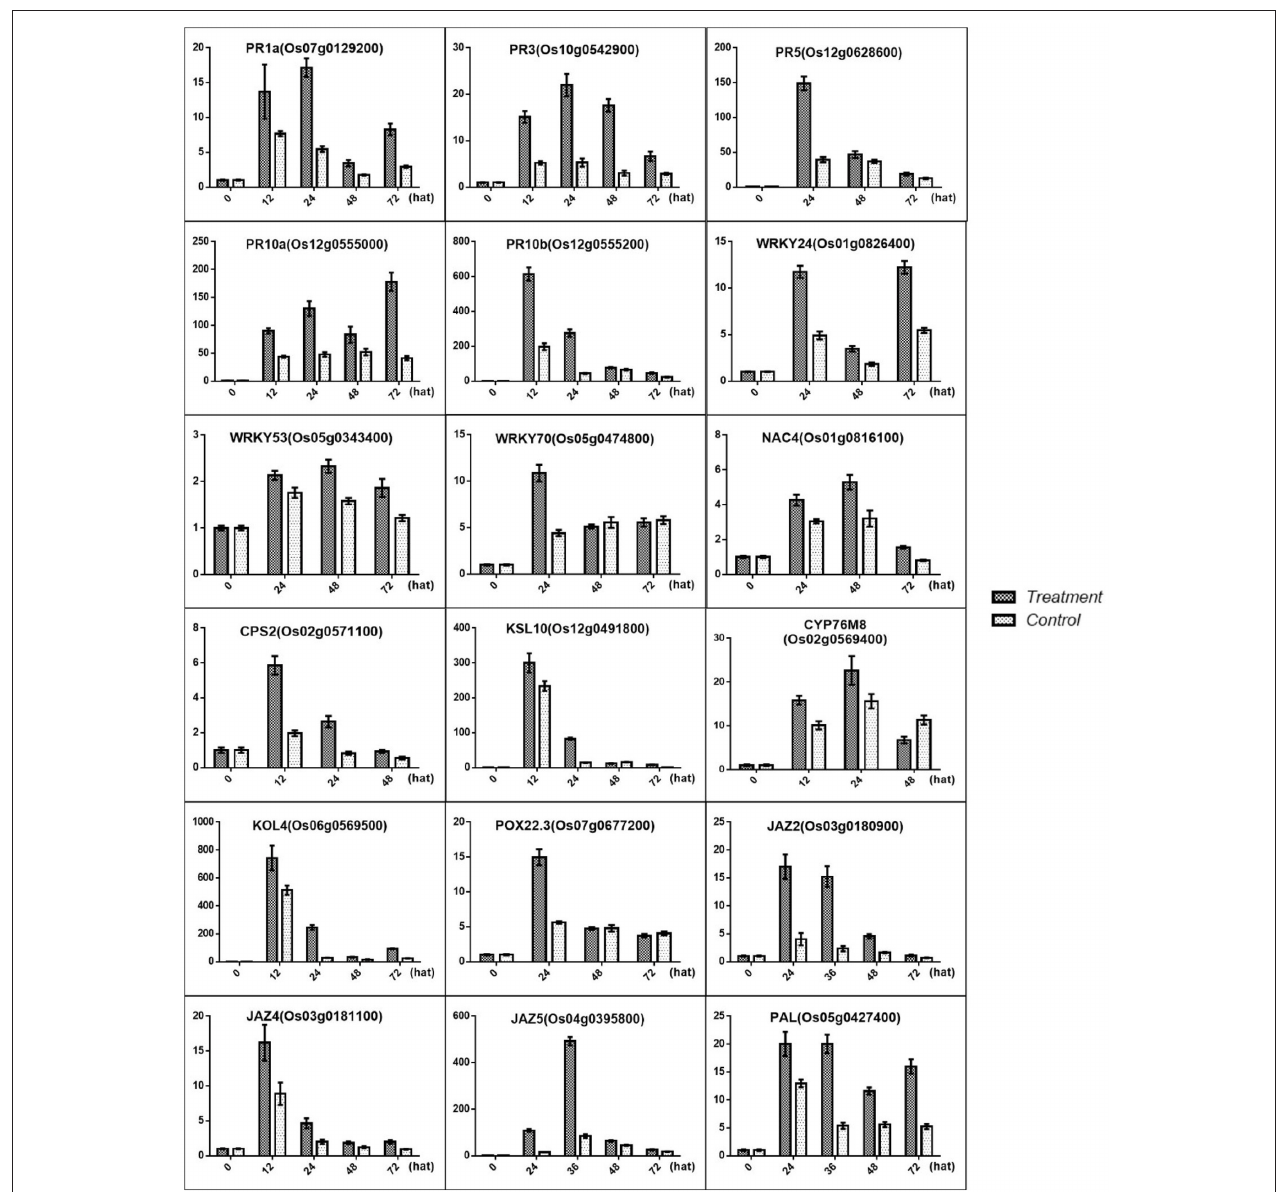
FIGURE 10 | Validation of the DGE transcriptome results by qRT-PCR for the genes involved in the resistance induced by MoHrip1 in rice. The expression levels on the y-axis were relative to those of the non-treated samples (0 h) after normalization with the rice β -actin gene. The experiment was repeated three times, and the resulting data are presented as the average ± SD , with n = 3; hat: h after treatment.